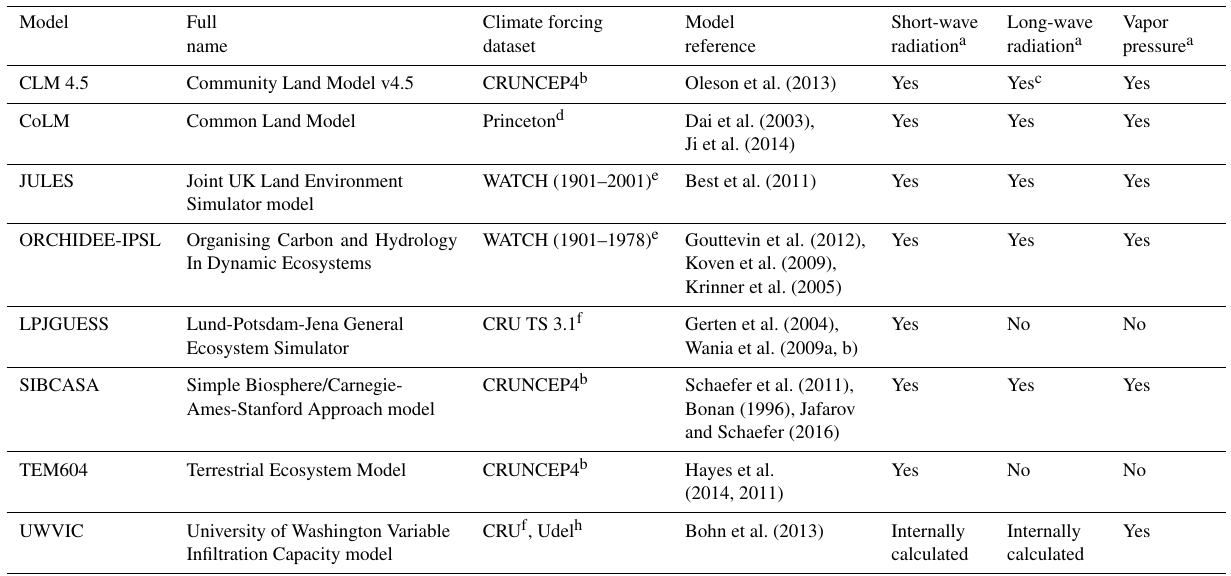
Table 1. Model descriptions and driving